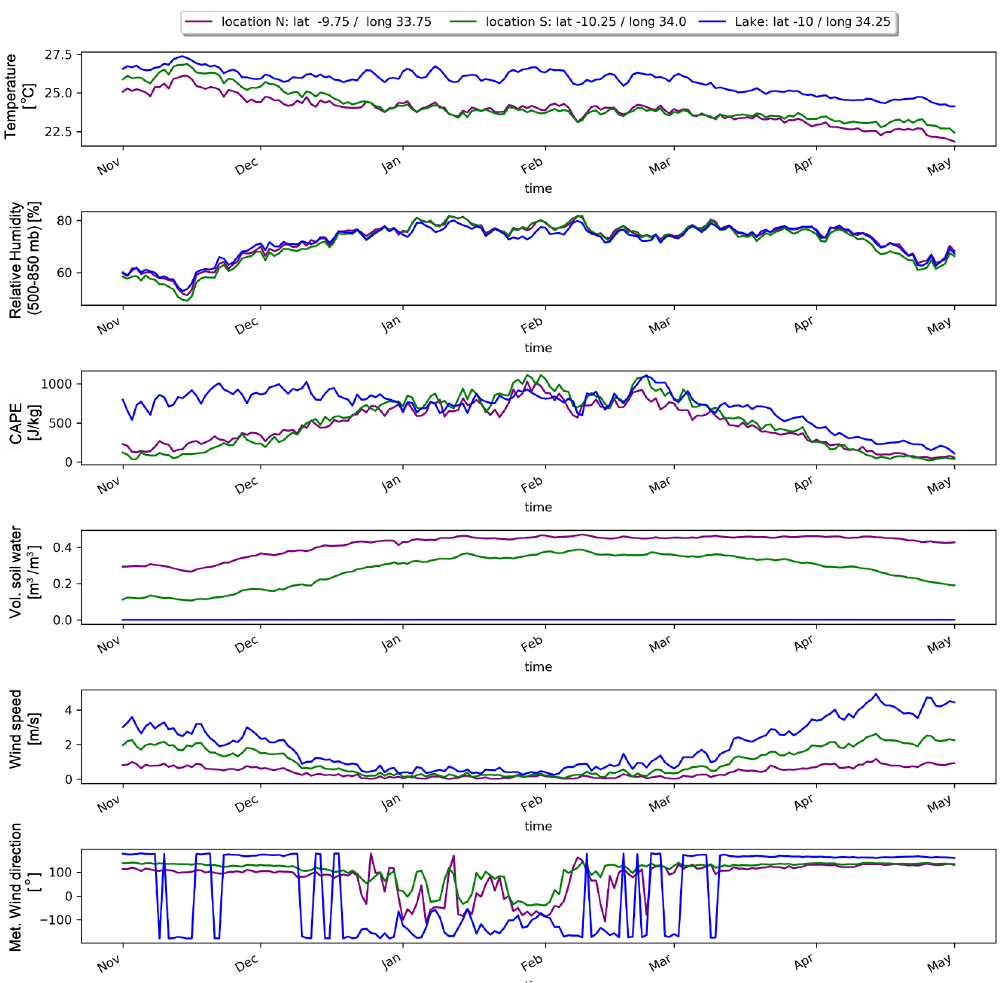
Figure 7. ERA5 standard daily averaged variables over the period 2000–2018 for the three locations as introduced in Fig. 3 representing the north and the south of Karonga and Lake Malawi. Six hydro-meteorological variables are shown: the surface temperature, the relative humidity of the troposphere, the CAPE factor, the volumetric soil water, the wind speed, and the meteorological wind